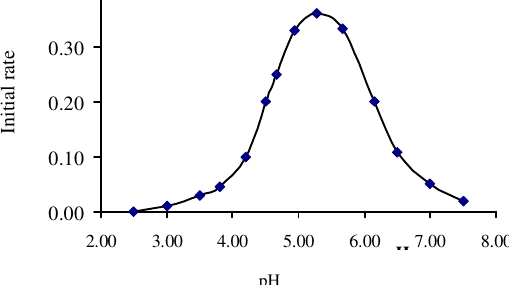
Figure 3. Influence of H + concentrations on the reaction to determine the optimum pH condition at λ = 656 nm, T = 36 o C, [DPKTH] = 5 x 10 -4 M, [Fe 3+ ] = 1 x 10 -4 M, max [Cysteine] = 2 x 10 -4 M and 10%